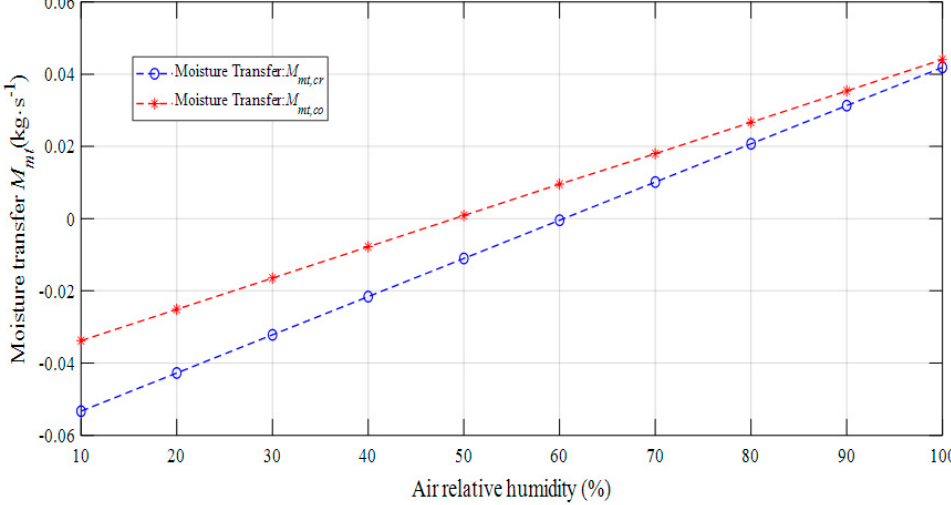
Figure 19. Influence of the relative humidity on moisture transfer.